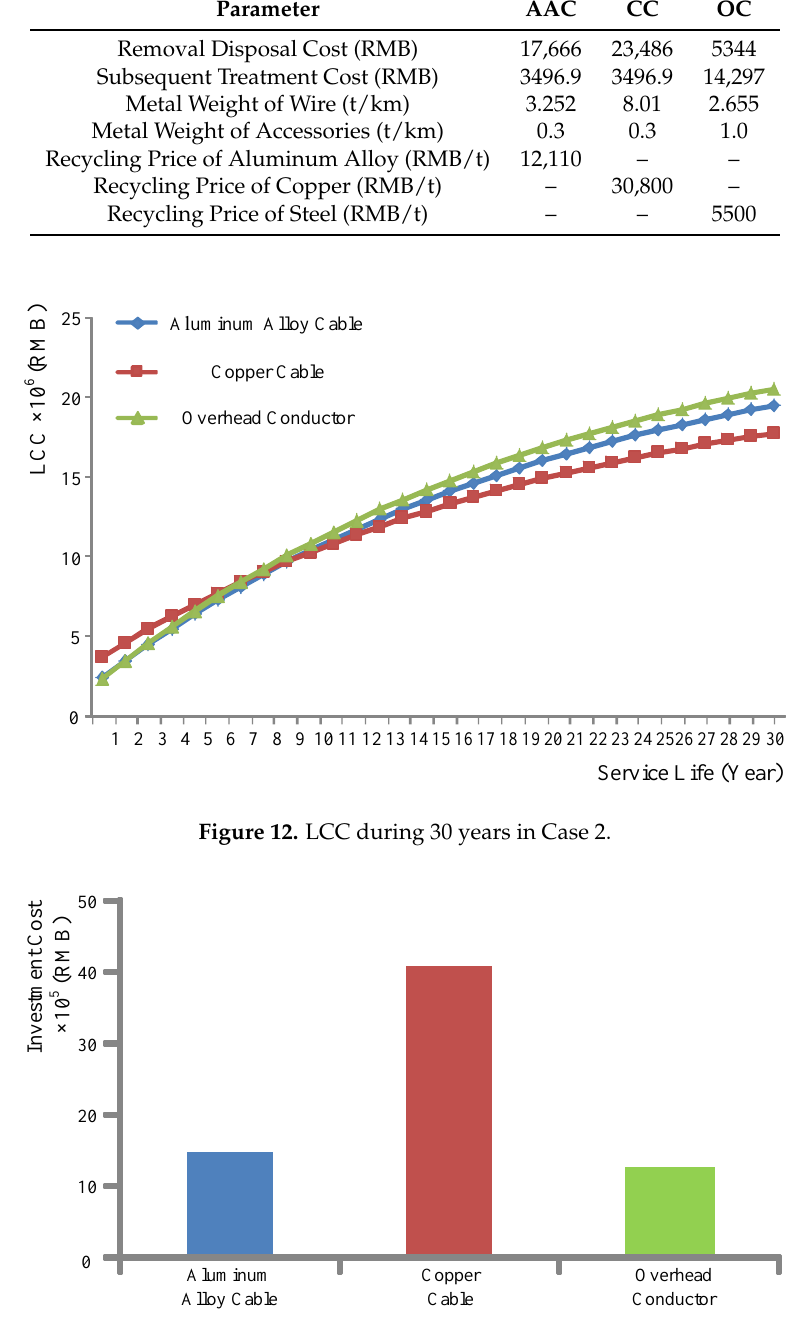
Figure 13. Investment cost during 30 years in Case